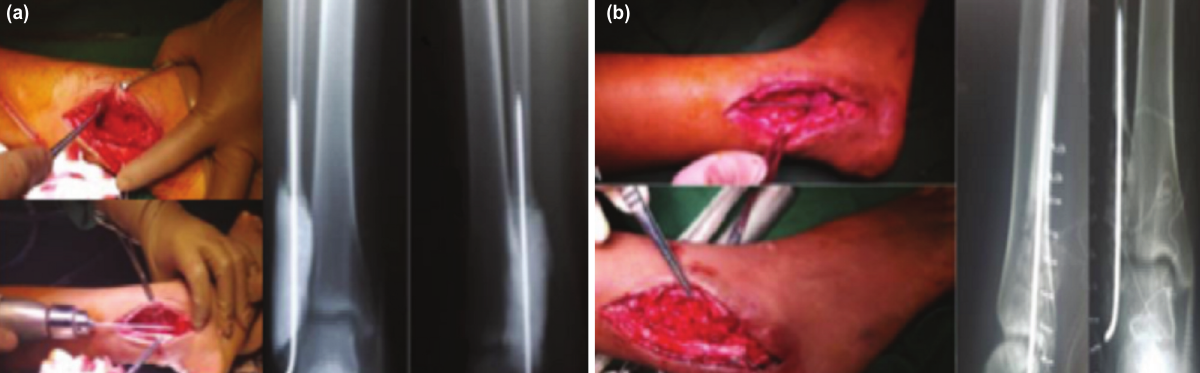
First and second stage procedure of the Masquelet technique. (a) After application of PMMA spacer. (b) Removal of the PMMA Fig. 2: spacer and application of autologous